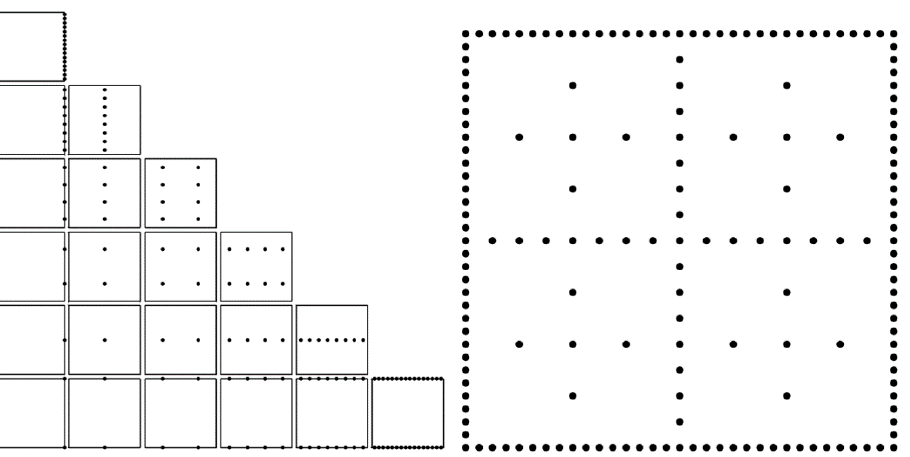
Figure 5. Sparse grid of the level n = 4, which takes into account boundary values.